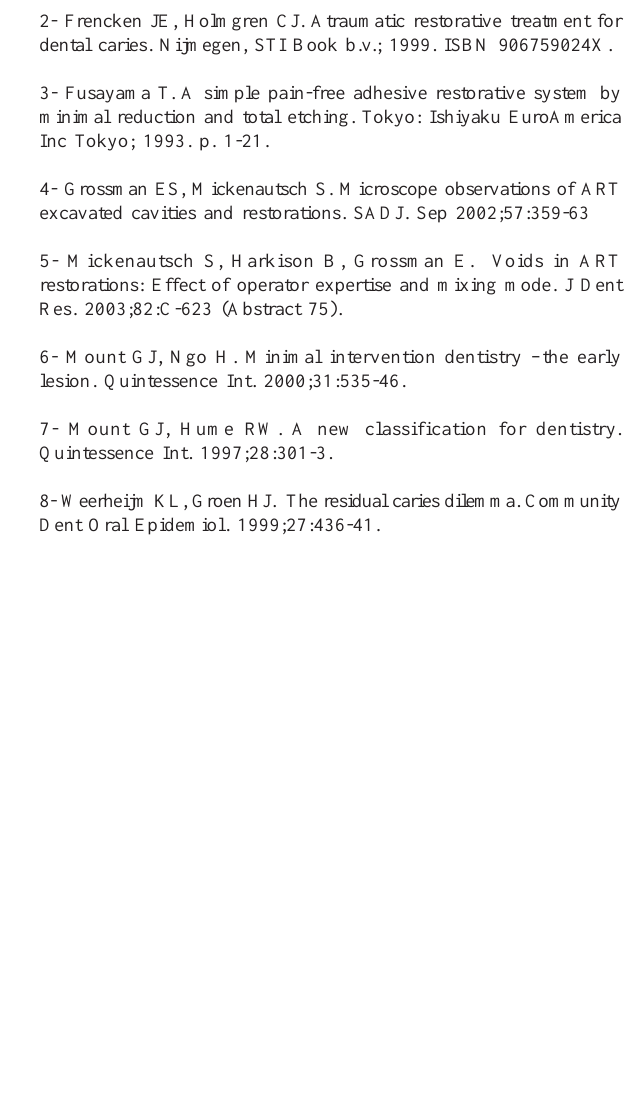
TABLE 2- ART failure